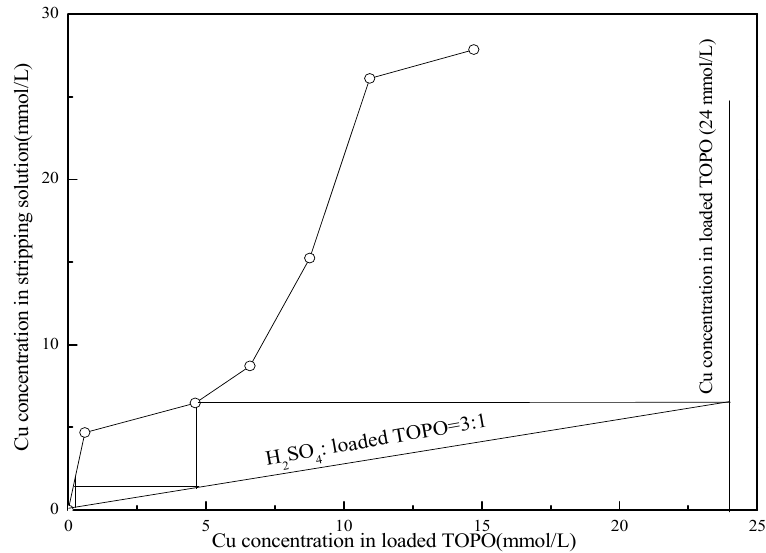
Figure 12. A McCabe–Thiele plot for Cu stripping with H 2 SO 4 from Cu-loaded TOPO.